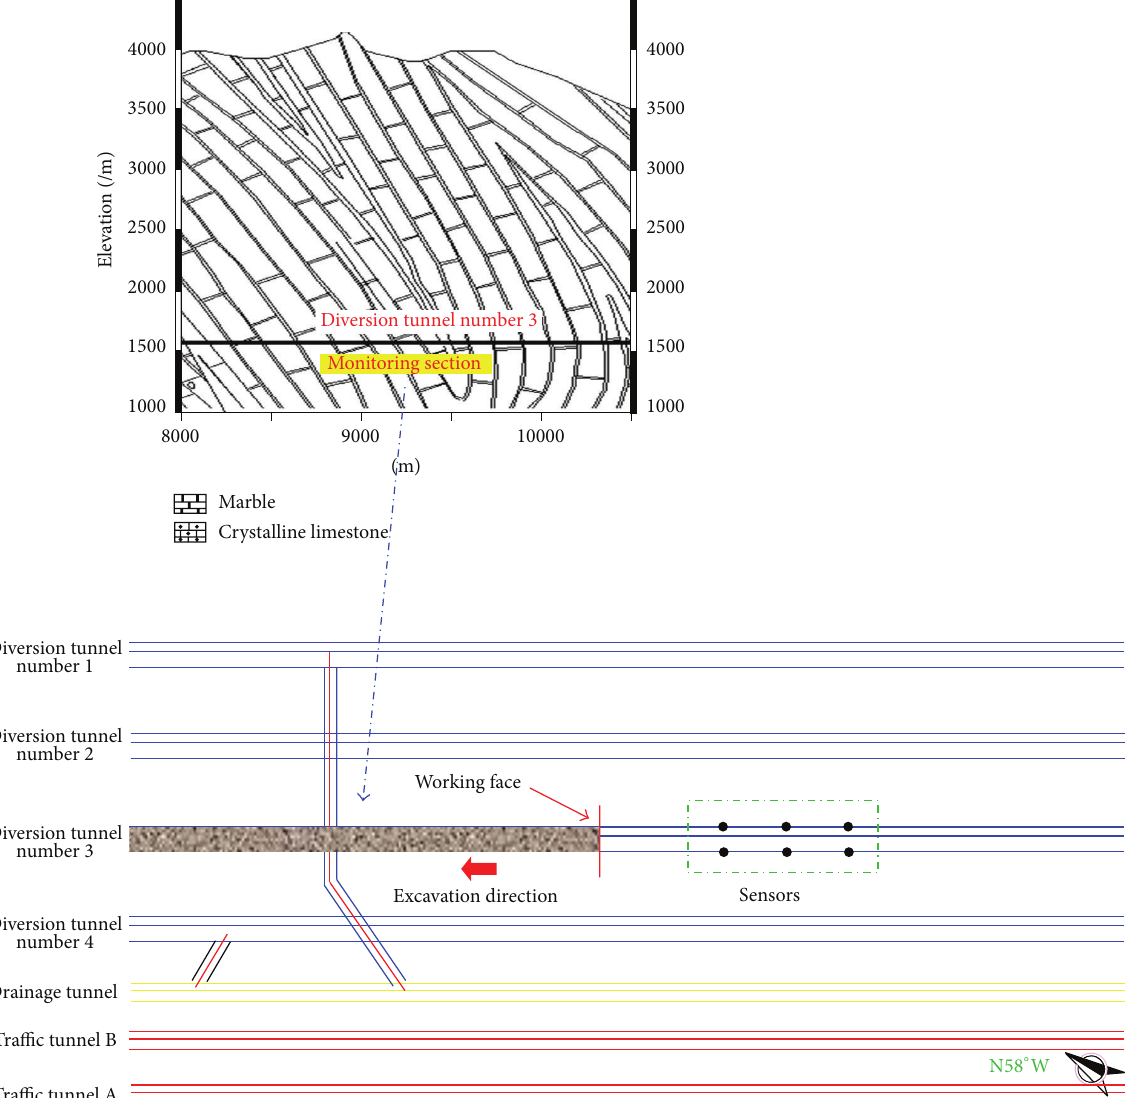
in the rockburst nucleation process. Each microseismic event represents one microcrack. Greater densities of